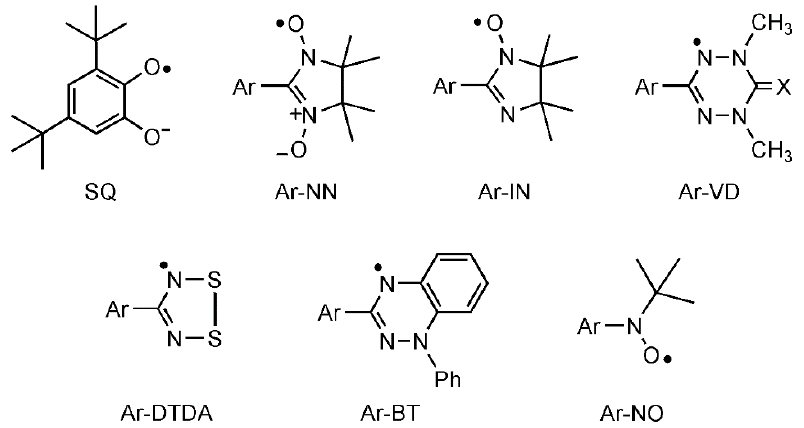
Figure 2. Structural formulas. Abbreviations: SQ, semiquinonate; NN, nitronyl nitroxide; IN, imino nitroxide; VD, verdazyl; DTDA, dithiadiazolyl; BT, benzotriazinyl; NO, tert -butyl nitroxide.